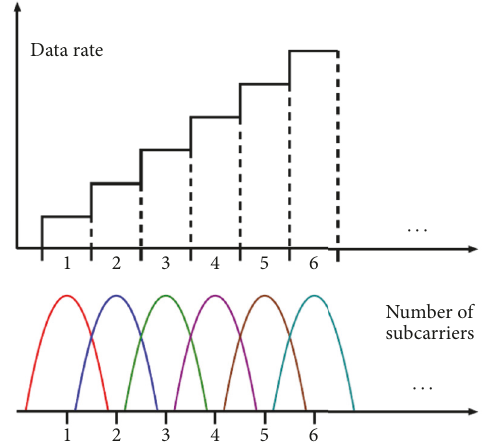
Figure 2: Data-rates as a function of number of subcarriers in an OFDM channel. Source